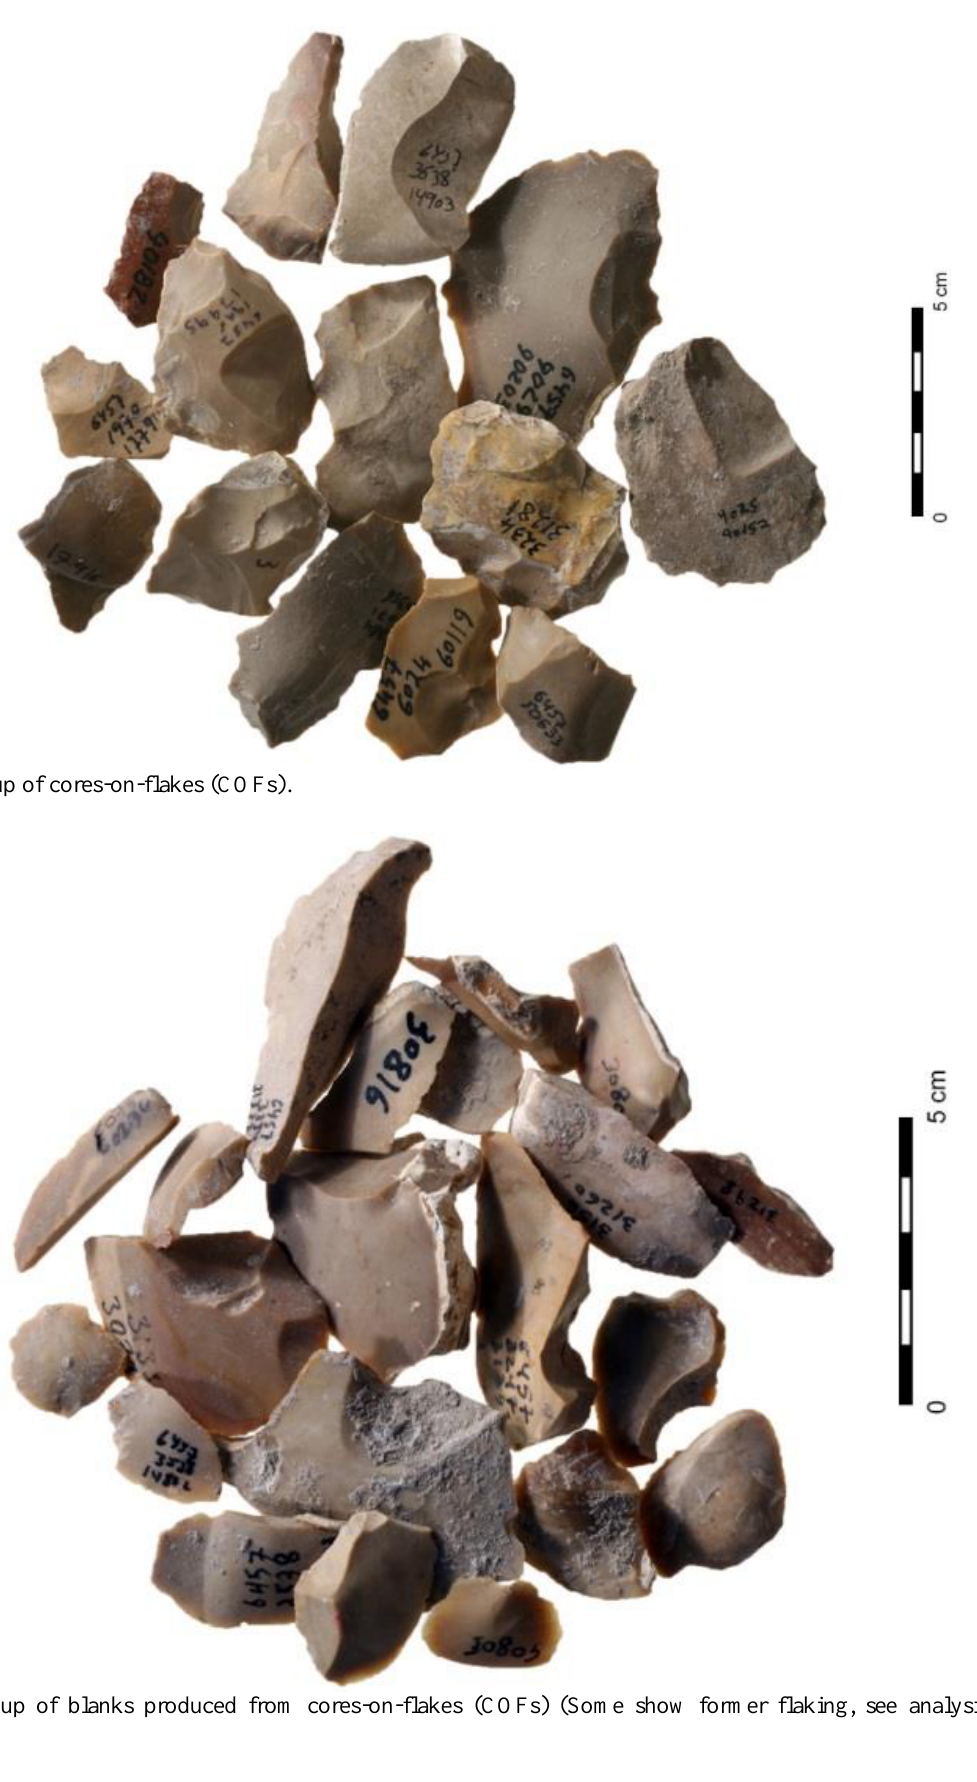
Figure 6. Group of blanks produced from cores-on-flakes (COFs) (Some show former flaking, see analysis